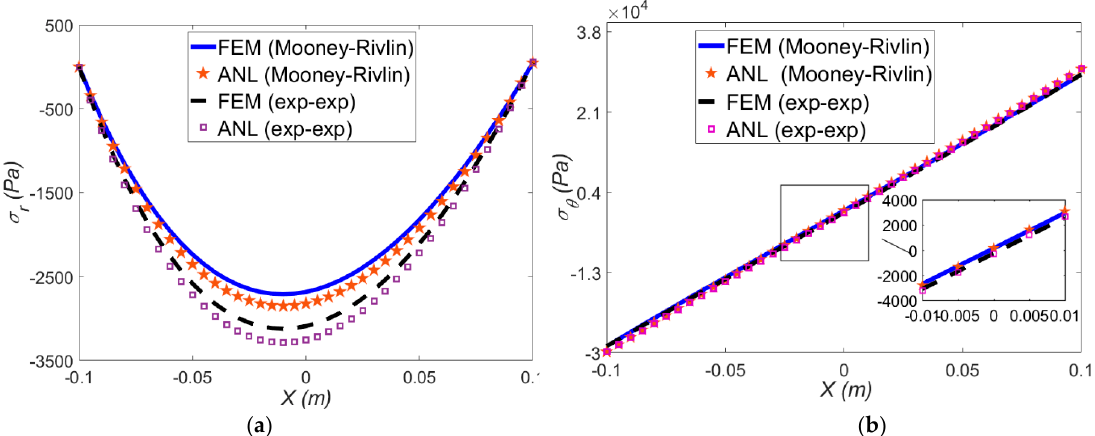
Figure 3. Variation of analytical and finite element method (FEM) ( a ) radial; ( b ) hoop stresses through the beam thickness with ρ = 0.5 m for two hyperelastic models. Analytical (ANL) stands for semi-analytical solution results.